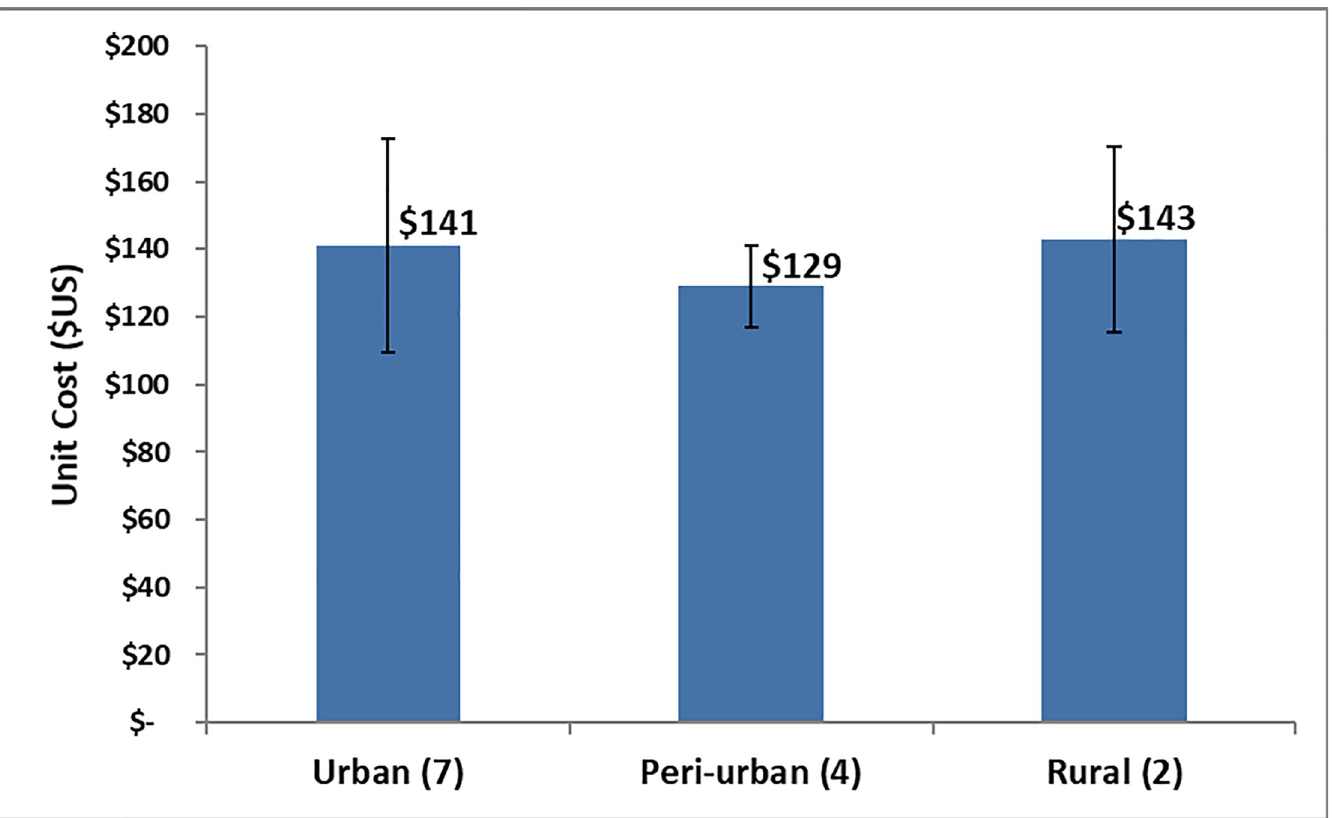
Fig 5. Unit cost by facility scale of